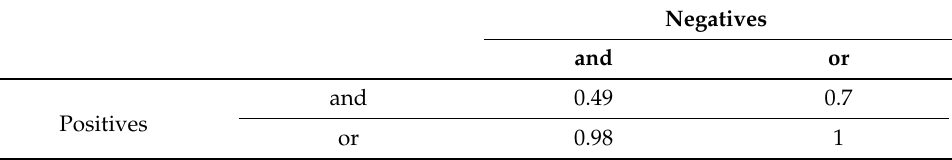
Table 3. AUCs for different combinations of logical operators used for the